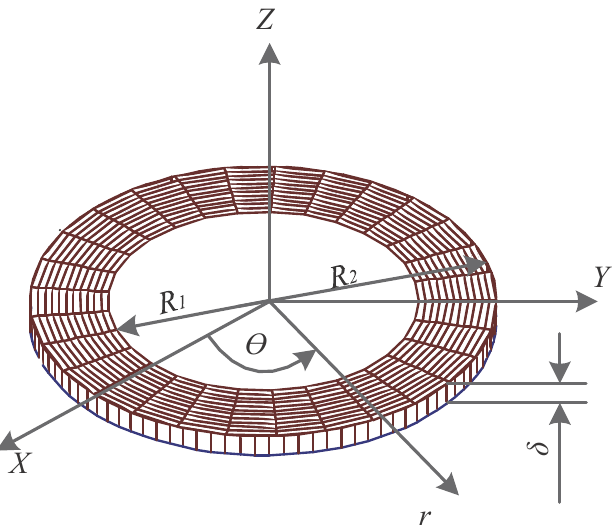
Figure 2. Schematic of the friction